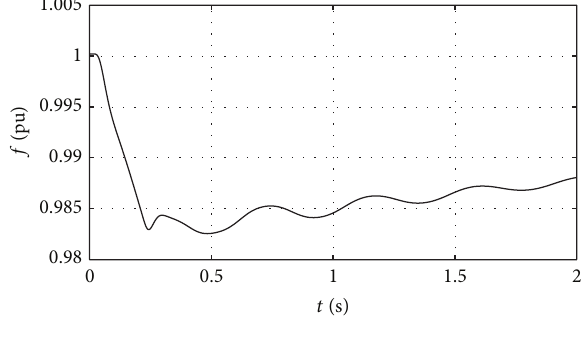
Figure 11: System frequency.